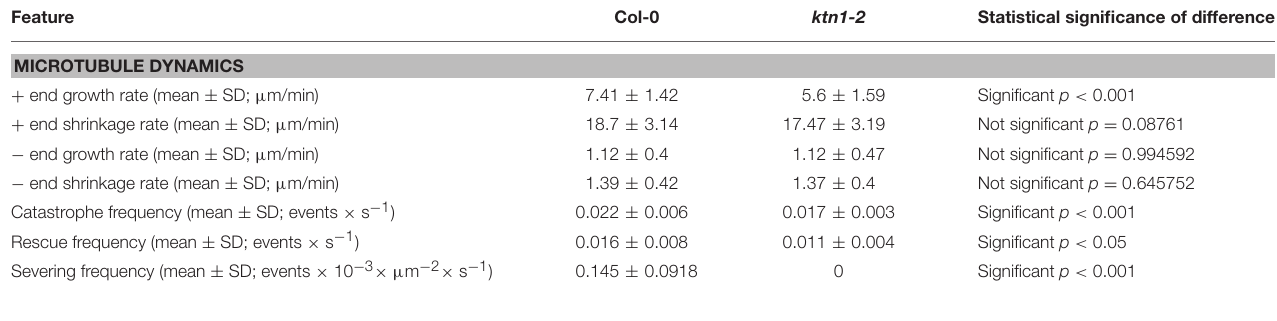
TABLE 1 | Features of microtubule dynamics in Col-0 and ktn1-2 mutant.